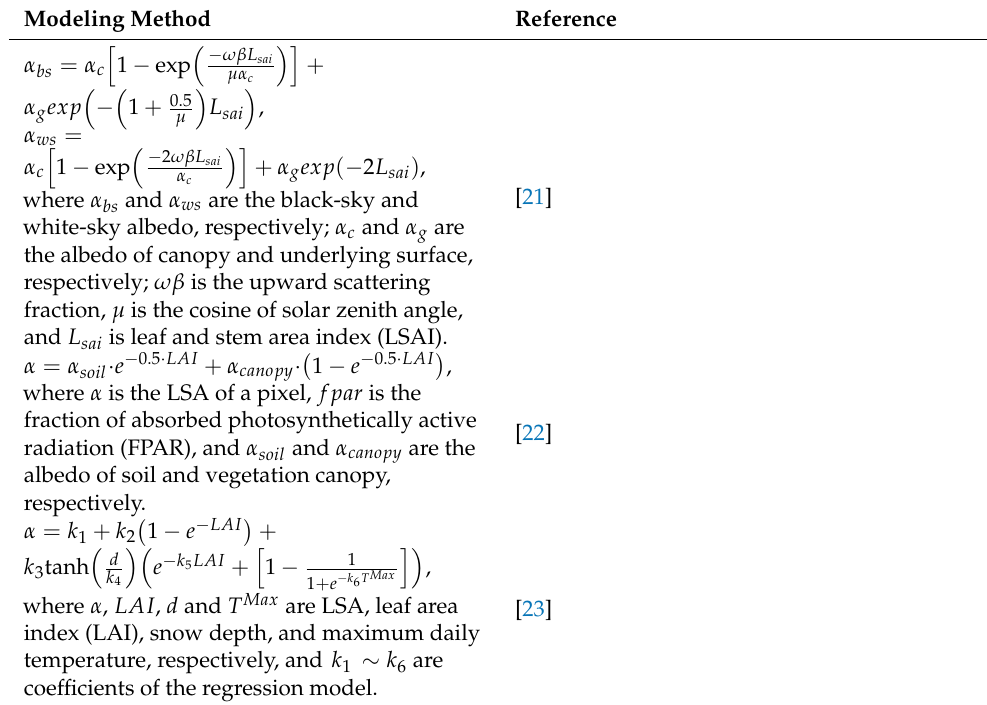
Table 1. Modeling methods of vegetation albedo at global and regional